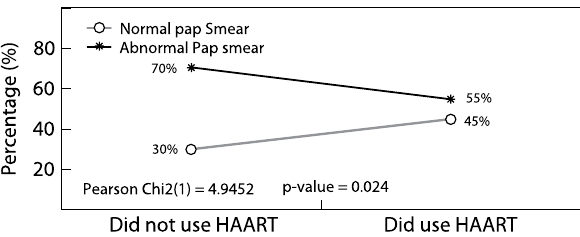
Figure 2: Association between the use of HAART with abnormal Pap smears.